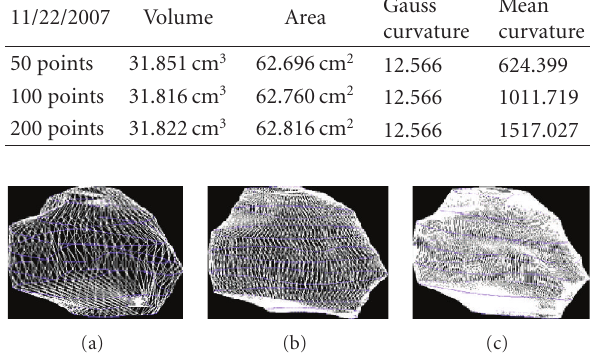
Figure 25: Patient 2. (a) 50 points on the contours, (b) 100 points on the contours, and (c) 200 points on the contours.